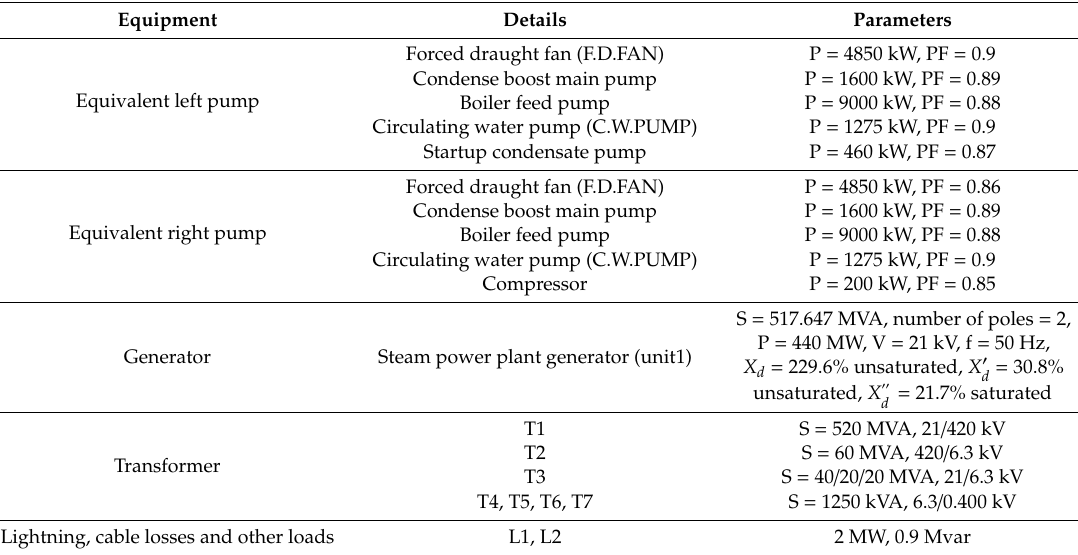
Figure 4. Schematic diagram of the auxiliary service network (ASS). Table 3. Nominal parameters of the Neka power plant network and its ASS.